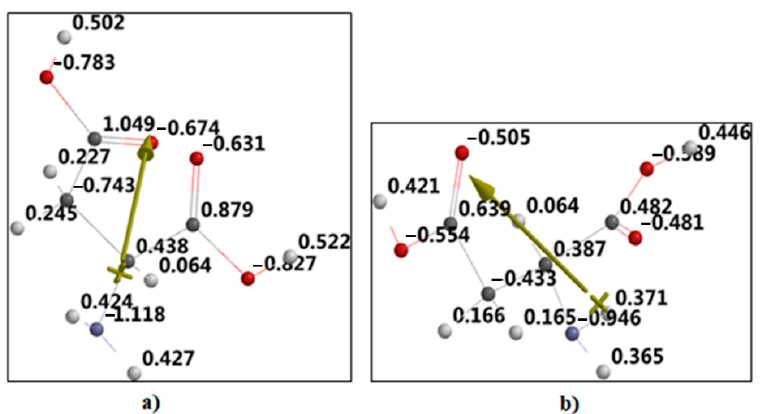
Figure 1. Electric charge distribution corresponding to optimized molecular structure in the two quantum-chemical approaches: ( a ) Hartree-Fock, ( b ) Density-Functional methods. Arrow represents the direction of the electrical dipole moment.